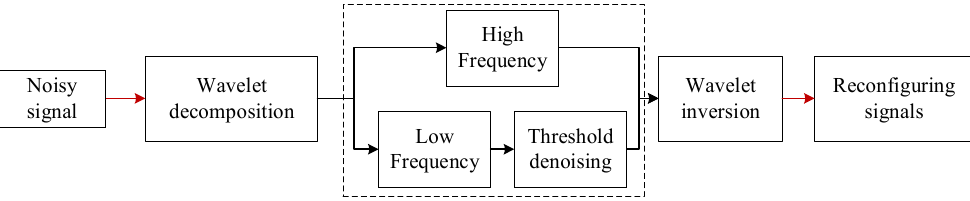
Figure 5. Flowchart of the wavelet denoising technique.